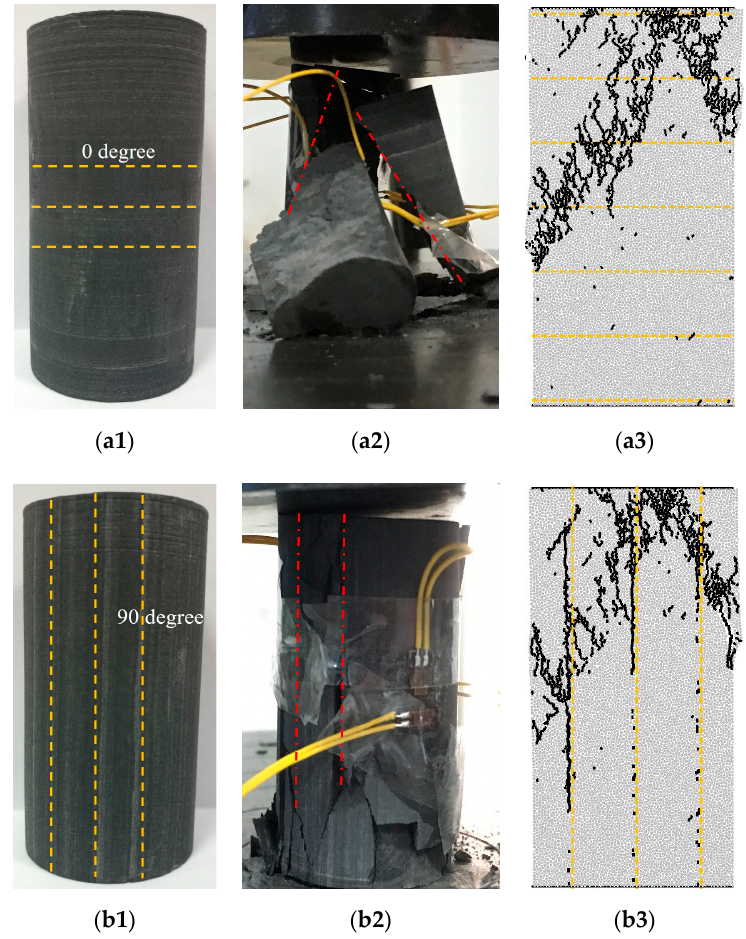
Figure 6. Comparison of final fracture morphology observed in experiments and simulations. The first letter ( a ): dip angle = 0 ◦ and ( b ): dip angle = 90 ◦ ; the second number 1: shale specimen, 2: in experiment; 3: in